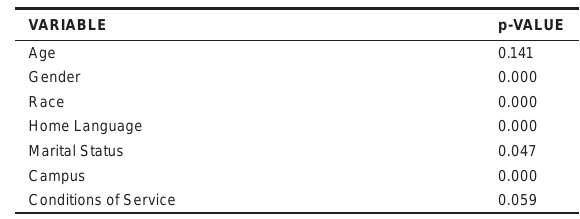
tABLe 1 Bias analysis